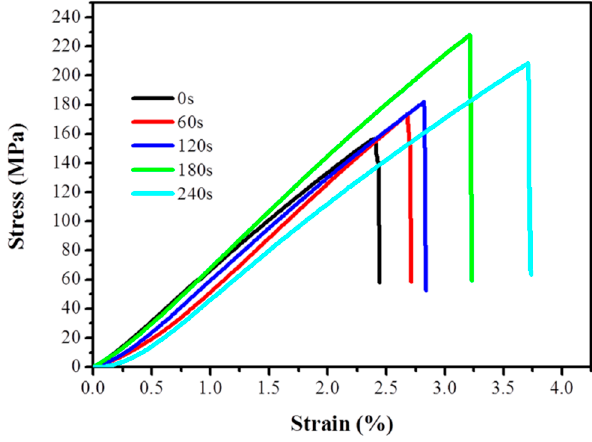
Figure 7. Stress–strain curves of pristine and plasma treated polyimide/poly(amic acid) (PI/PAA) composites.